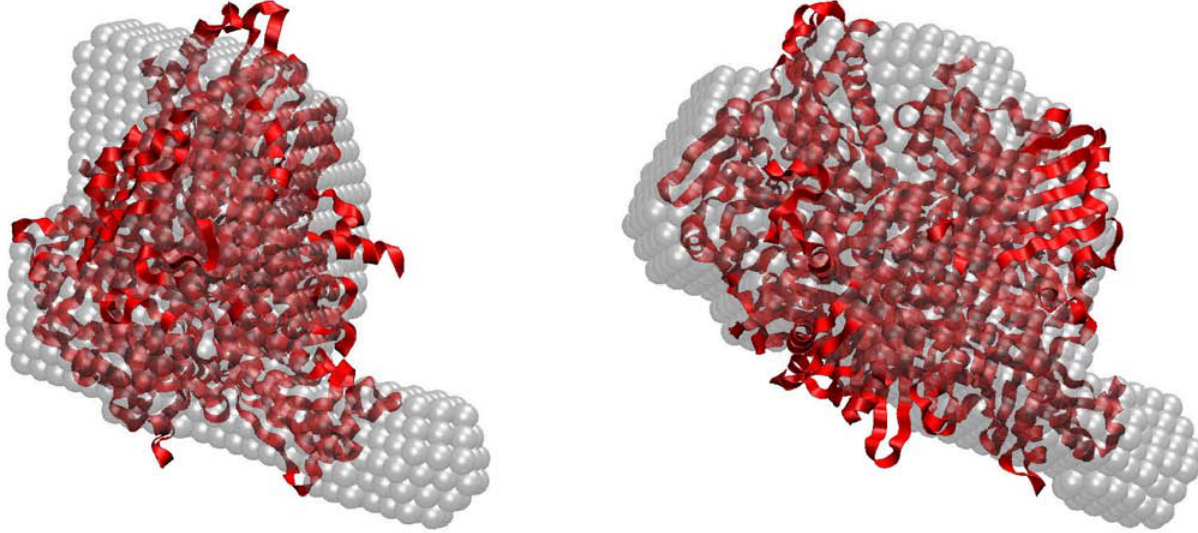
Figure 4. Superposition of the ab initio envelope of PaoABC (transparent beads, the most typical reconstruction from twenty DAMMIF runs) with the ribbon representation of the crystallographic monomer of 1rm6. Right panel is rotated 90 degrees counterclockwise along the vertical